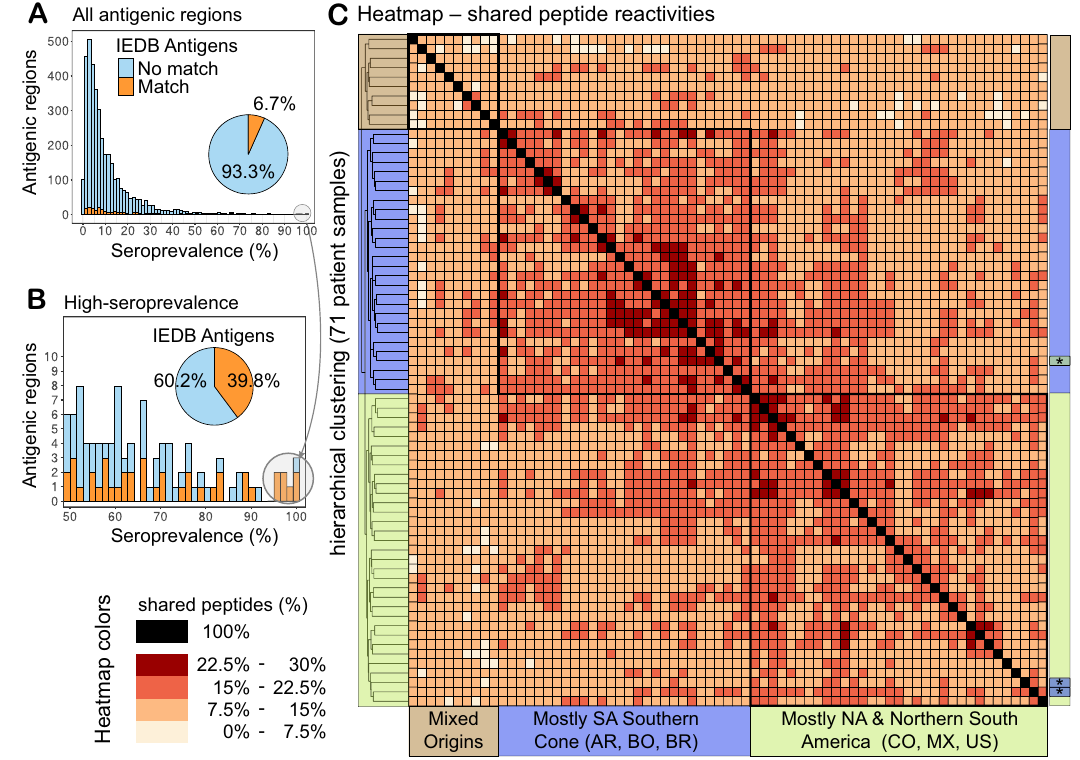
Fig.6|Pro fi lingofindividualantibodyresponsesrevealsthediversityofanti- T. cruzi -speci fi c antibodies. A Histogram showing the number of clusters of anti- genic regions that were reactive in each fraction of subjects (shown as ser- oprevalence). Sequence similarity to known antigens was assessed by BLASTP against T. cruzi linear epitopes in the IEDB (see Methods). Previously described antigens are shown in orange; antigens without matches to the IEDB are in light blue. B Inset zooming in on the 98 clusters reactive in at least 50% of the subjects